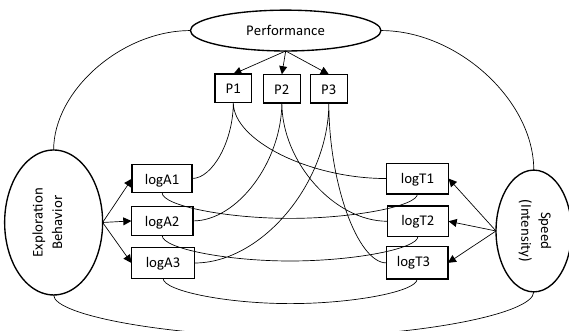
Fig. 1 Adaptation of De Boeck & Scalise’s (2019) three‑factor model for the analysis of three items in a test. While P1, P2, and P3 measure the response accuracy to the three items in binary outcomes (0 1 correct answer), T1, T2, and T3 refer to response times, and A1, A2, and A3 refer to the frequency of actions = for each item, respectively. The single‑headed dashed arrows indicate the direct effect. The curves between the observed variables or latent variables indicate the